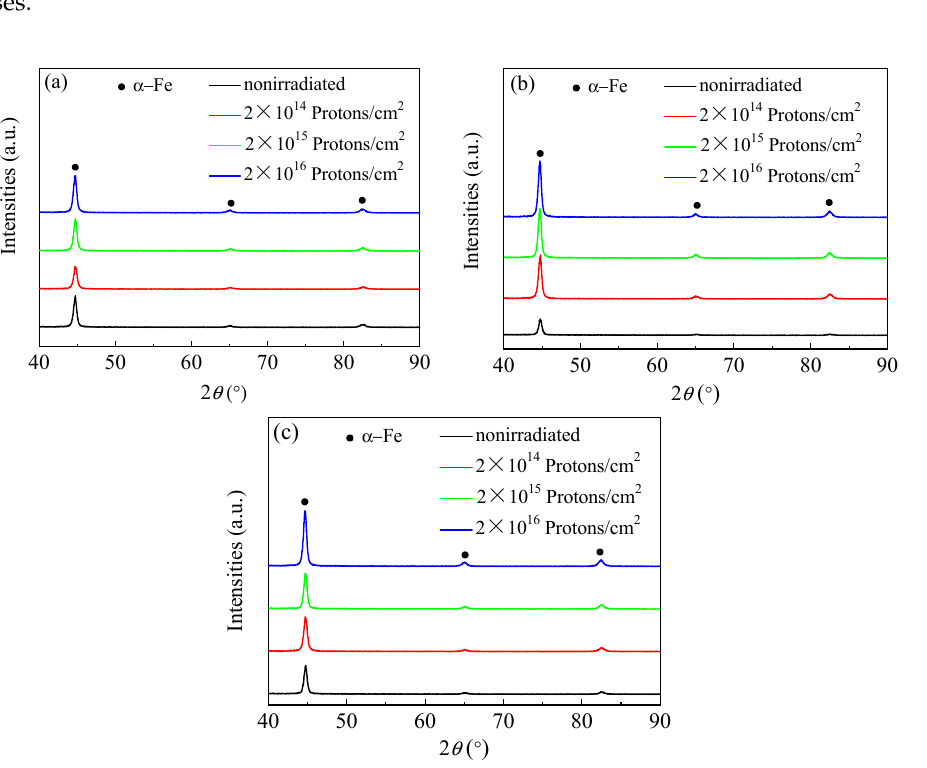
Figure 2. XRD diffraction patterns of 5140 steel irradiated by proton at different tempering temperatures: ( a ) 480 °C tempering, ( b ) 520 °C tempering, ( c ) 560 °C